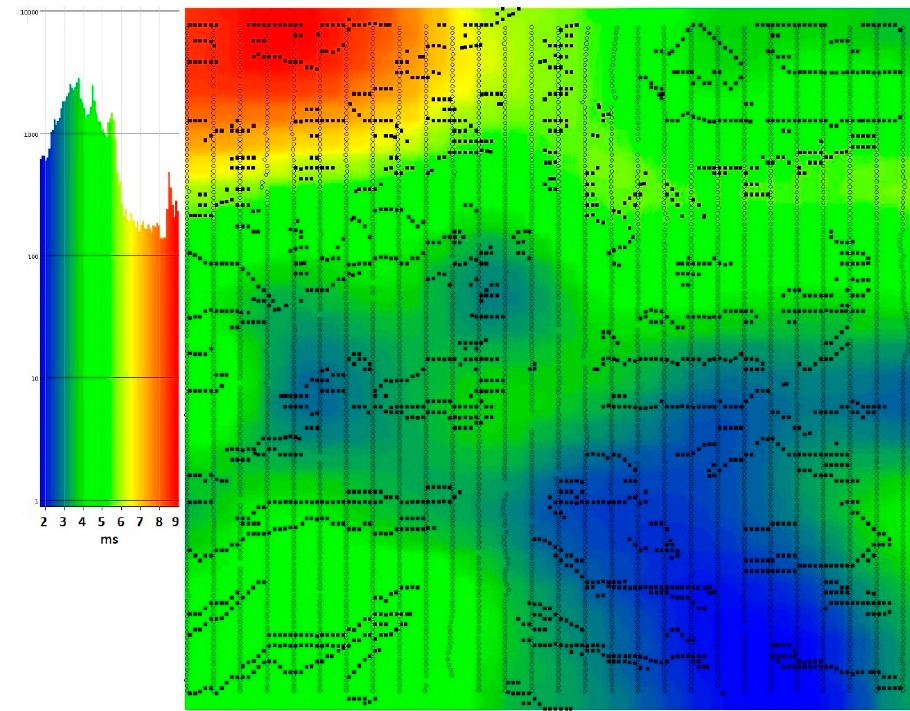
Figure 9. A map of anisotropy magnitude. The circles represent receivers, and the squares represent sources.